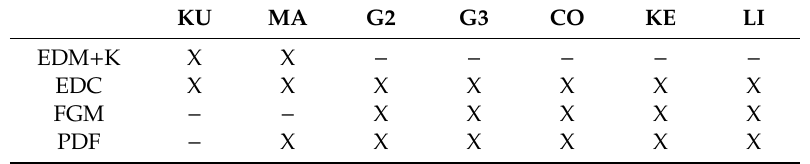
Figure 6. Variation of calculated centerline temperature at x / d = 10 with grid resolution (KU-EDM + K). Not all turbulent combustion models were used in combination with all reaction mechanisms. An overview of the investigated combinations is provided in Table 4, where a cross (X) means that the combination was investigated, and a minus ( − ) means that the combination was not considered. Table 4. Investigated combinations of turbulent combustion models and reaction mechanisms.